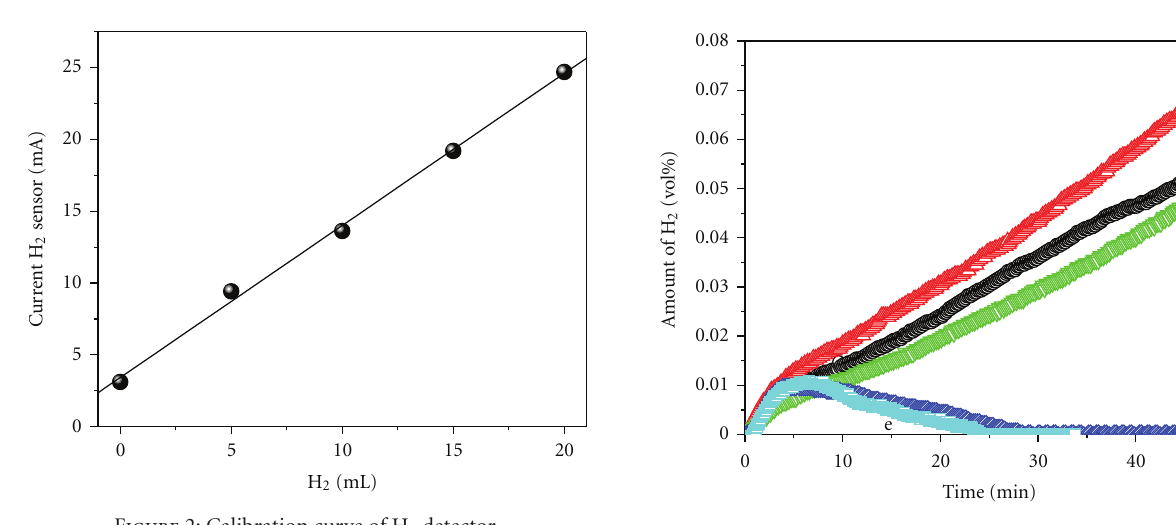
Figure 2: Calibration curve of H 2 detector.